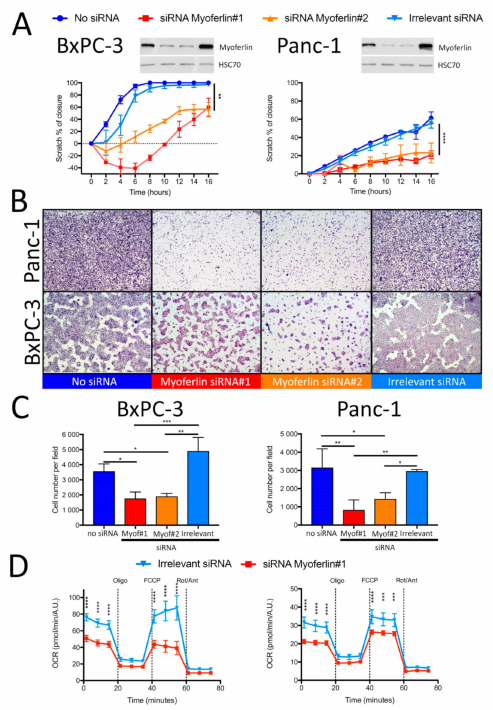
Figure 3. Myoferlin is required for PDAC cell migration and OXPHOS. BxPC-3 and Panc-1 cells were silenced for myoferlin with two di ff erent small interfering RNAs (siRNAs). ( A ) Two-dimension migration kinetic assay (scratch assay) of BxPC-3 and Panc-1 cell lines silenced for myoferlin. ( B ) Representative images of 3D migration evaluated in Boyden’s chamber for 24 h. ( C ) Quantification of migrating BxPC-3 and Panc-1 depleted for myoferlin in the lower compartment of Boyden’s chamber. ( D ) Kinetic oxygen consumption rate (OCR) response of irrelevant or myoferlin siRNA-transfected BxPC-3 and Panc-1 cells to oligomycin (oligo, 1 µ M), FCCP (1.0 µ M), and rotenone and antimycin A mix (Rot / Ant, 0.5 µ M each). Upon assay completion, cells were methanol / acetone fixed, and cell number was evaluated using Hoechst incorporation (arbitrary unit, A.U.). One representative experiment out of three is illustrated. Same results were obtained with the second myoferlin siRNA. Each data point represents mean ± SD, n = 3. **** P < 0.0001, *** P < 0.001, ** P < 0.01, * P <